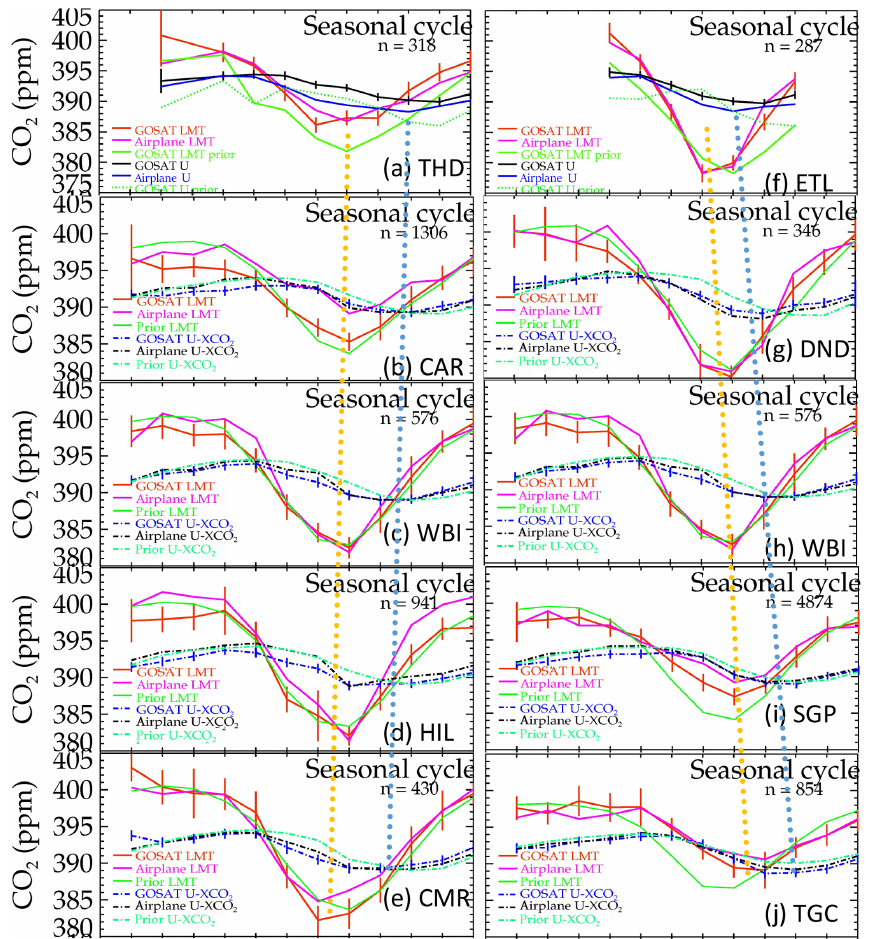
Figure 7. Seasonal cycle at five sites arranged from west to east (a–e) and north to south (f–j) for GOSAT LMT (red), aircraft LMT (pink), GOSAT LMT prior (green), GOSAT U (blue dashed), aircraft U (black dashed), and GOSAT U prior (green dashed). The seasonal cycle minimum is marked for LMT (orange dotted) and U (blue